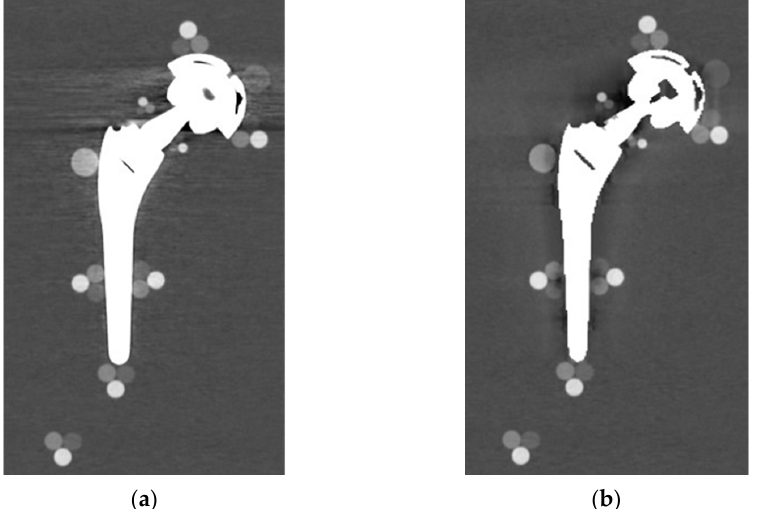
( b ) Figure 4. SS unilateral configuration, coronal reconstruction (bone CT visualization window WL:300, WW:1500 ( a ) VMI reconstructed at 90 keV; and ( b ) VMI reconstructed at 90 keV + MARS. The qualitative impact of MARS application can be seen in Figure 3b for TI and in Figure 4b for SS. Streak artifacts disappeared on both unilateral configurations, and grey levels were more homogeneous all around the metal devices, but new MARS ‐ related ar ‐ tifacts were generated. In particular, the reconstruction of the two prosthetic profiles pre ‐ sented a stepped appearance (Figures 3b and 4b), with a significant reduction in the ap ‐ parent sizes. Some halos of grey levels were still present around the periprosthetic area of the stems (Figures 3b and 4b), as can be also verified in the triplets and in the PMMA cylinder with calibrated HA.